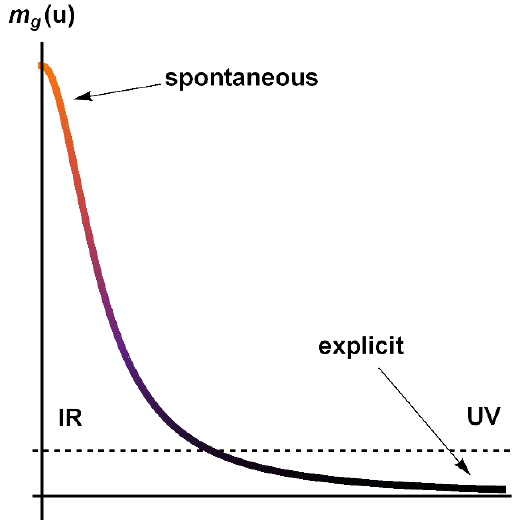
Figure 1 . A sketch of the behaviour of the graviton mass as a function of the holographic coordinate u . The dashed line represents the mass pro(cid:12)le in the models [8]. The colored line is the setup which we analyze in this work and where we would expect a propagating gapped phonon to appear in the spectrum with a small mass gap ! 0 controlled by the UV graviton mass. In practice, one can achieve this hierarchy using the HMG models of the form (1.3) with large enough N and (cid:12)